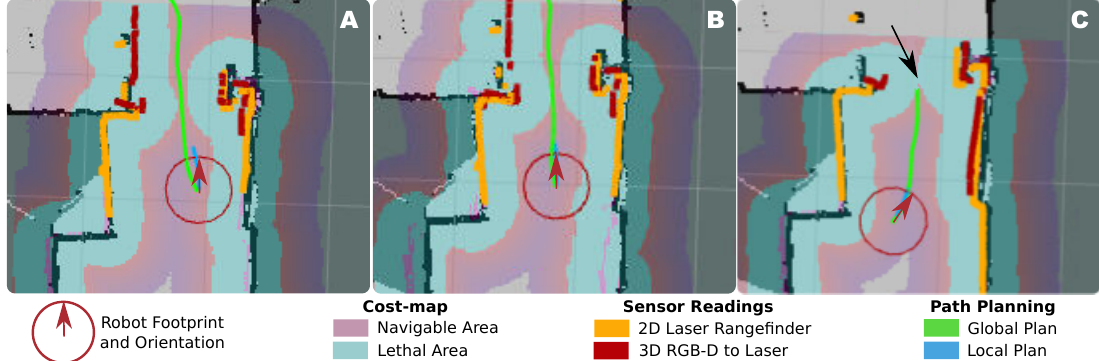
Figure 1. Illustration of three different situations ( A – C ) experienced by a mobile robot when traversing a door. The navigable area is, as perceived by the robot, the result of multiple factors like its localization, the obstacles detected by the on-board sensors, and their corresponding errors. The latter have an important impact in the surroundings of narrow areas (i.e., the door) as the robot may perceive there is not space for it to pass